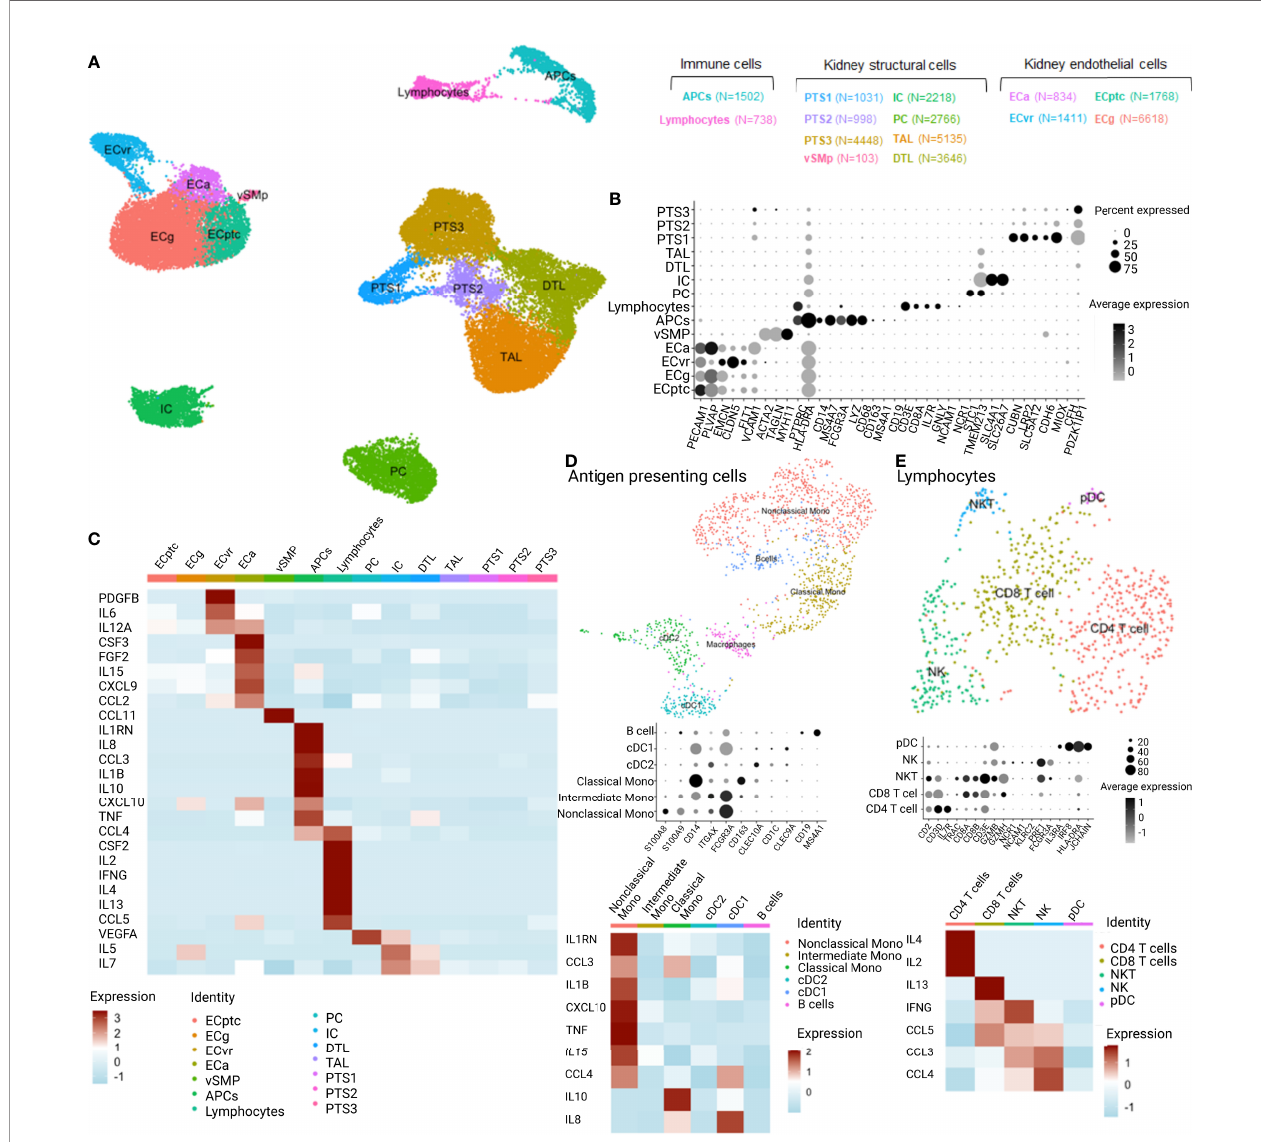
FIGURE 3 | Single-cell RNASeq analysis of the expression distribution of the cytokines of interest across the different cell types distinguished in 7 kidney biopsies analyzed with scRNASeq (2 ABMR, 5 transplant surveillance biopsies). APCs,antigen-presenting cells; PTS, proximal tubular cells; vSMp, vascular smooth muscle and pericytes; IC, intercalated cells; PC, principal cells; TAL, thick ascending loop of Henle; DTL, descending thin limb; ECa, activated endothelial cells; ECvr, endothelial cells of vasa recta; ECptc, endothelial cells of peritubular capillaries and ECg, endothelial cells of glomerulus; cDC, classical dendritic cells; pDC, plasmacytoid dendritic cells; NK, natural killer cells; NKT, natural killer T cells. (A) UMAP dimensionality reduction of the different cell types clusters and their relation. (B) Dotplot of the identi fi ed cell type cluster based on speci fi c marker features. (C) Heatmap of the cytokine pro fi les from the clinical experiment and corresponding expression in the cell types of 7 kidney biopsies. (D) UMAP, dotplot, and heatmap of the antigen-presenting cell cluster and cytokine expression. (E) UMAP, dotplot, and heatmap of the lymphocyte cluster and cytokine